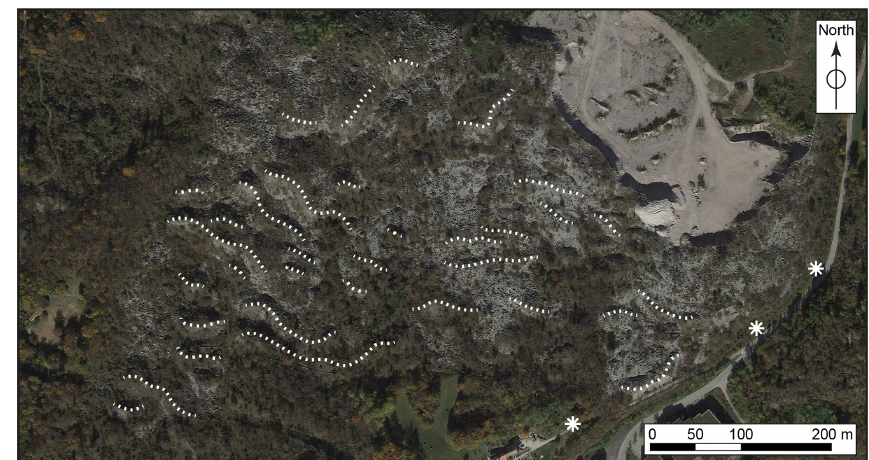
Figure 6. Transverse ridges in the southwestern part of the Masiere sector (basemap source: © Google Earth). Location of image shown in Fig. 3. The rock avalanche moved (from north to south) over a slight topographic high made up of Pleistocene conglomerate (see Fig. 4); the ridges are interpreted as compressional. White stars indicate locations where the contact between the rock avalanche and the conglomerate is